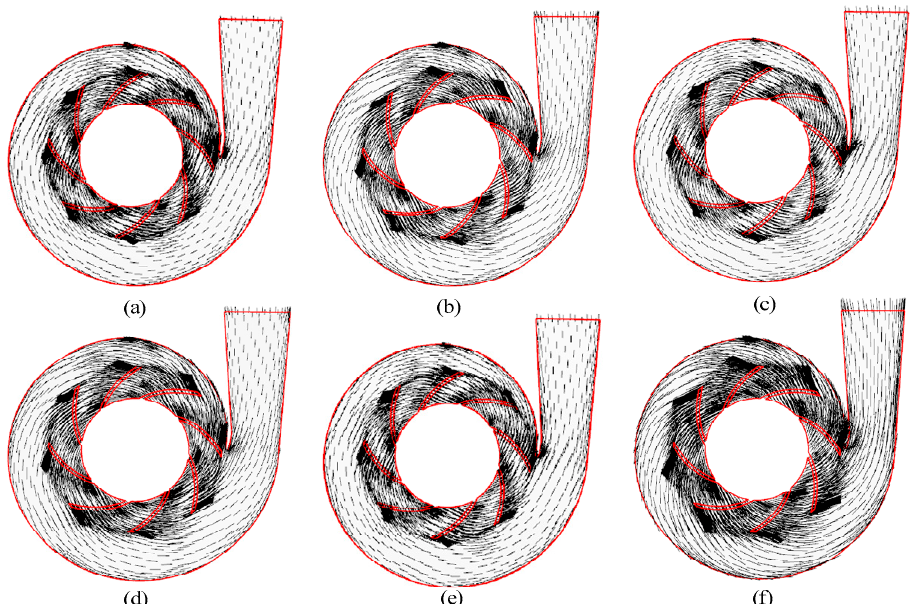
Figure 10. Comparisons of velocity vectors at the axial section between the combination impeller and the conventional impeller: ( a ) combination impeller, 0.8 Q d ; ( b ) combination impeller, 1.0 Q d ; ( c ) combination impeller, 1.2 Q d ; ( d ) conventional impeller, 0.8 Q d ; ( e ) conventional impeller, 1.0 Q d ; ( f ) conventional impeller, 1.2 Q d .